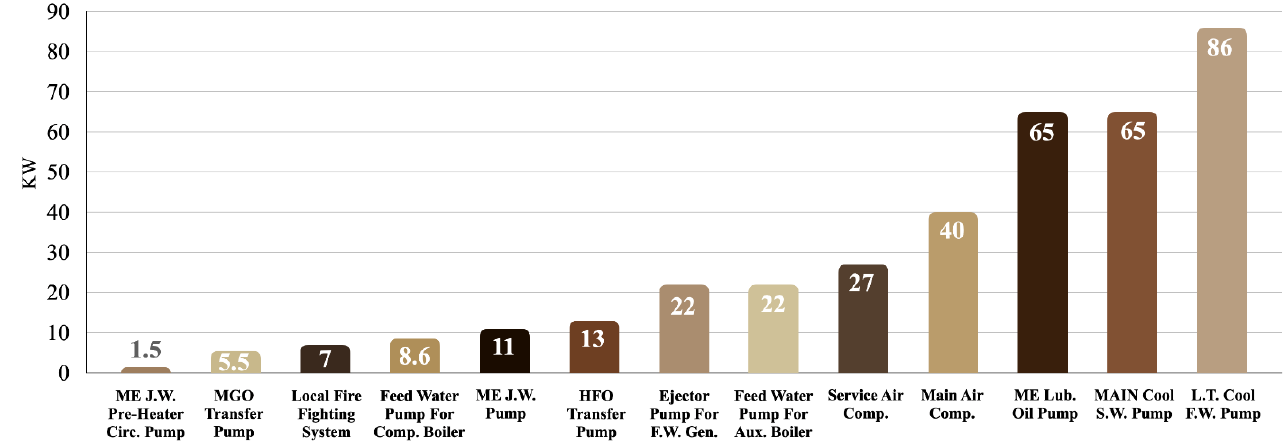
Figure 5. Power needs for the ship’s auxiliary machineries.